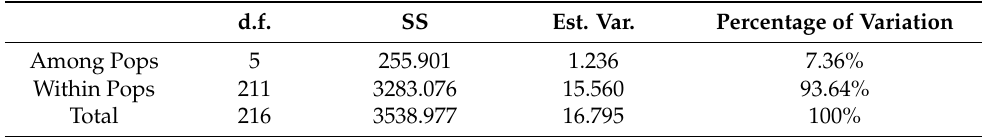
Table 2. Analysis of molecular variance (AMOVA) of 217 radish accessions. d.f. SS Est. Var. Percentage of Variation Among Pops 5 255.901 1.236 7.36% Within Pops 211 3283.076 15.560 93.64% Total 216 3538.977 16.795 100%